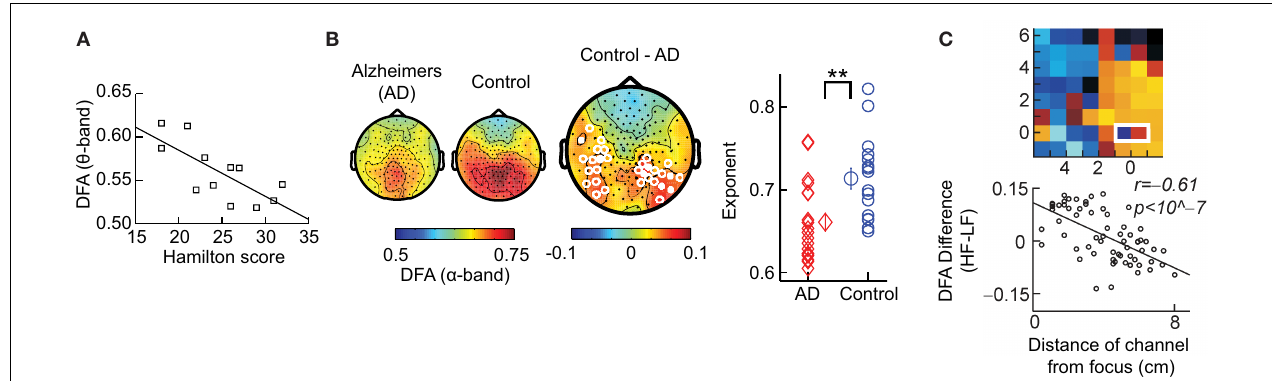
FIGURE 8 | DFA is a promising biomarker for pre-clinical studies. (A) DFA exponents of theta oscillations in left sensorimotor region correlate with the severity of depression based on the Hamilton score. Data recorded from 12 depressed patients with MEG, during an eyes-closed rest session of 16min. (Figure modified from Linkenkaer-Hansen et al., 2005). (B) DFA of alpha oscillations shows a significant decrease in the parietal area in patients with Alzheimer’s disease than in controls. MEG was recorded during 4min of eyes-closed rest and the DFA exponent estimated in the time range of 1–25s.